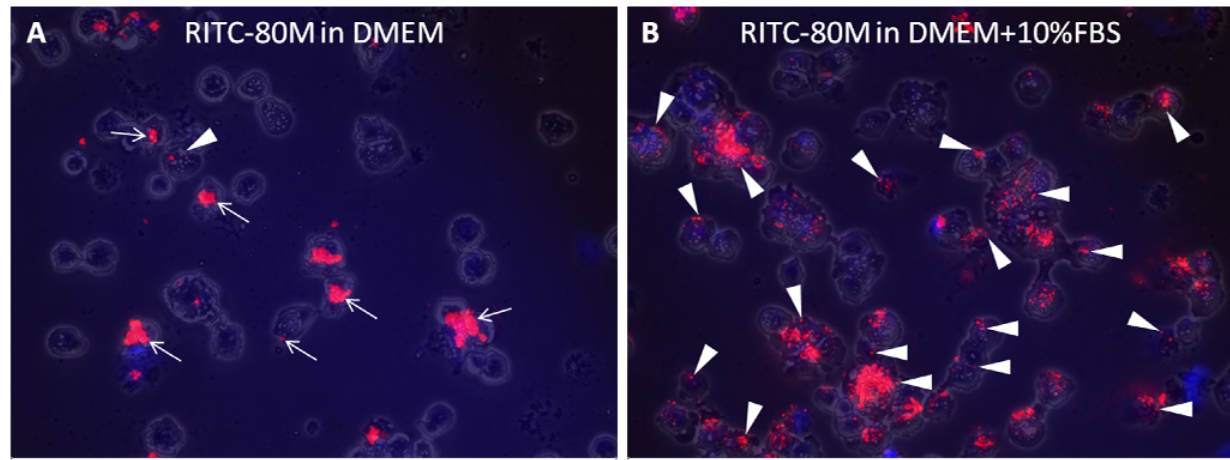
Figure 8. Merged epifluorescent-brightfield images of cytospins of HEK293 cells submitted to flow cytometry after culturing 24 hours with RITC-80M in DMEM ( A ) or in DMEM+10% FBS pH 7.4 ( B ). Red signal is RITC-chitosan, blue is Hoechst 33346-stained DNA. Symbols: arrows: extracellular RITC-80M adsorbed to cell surfaces as shown by the non-uniform microparticle shape; arrowhead: intracellular vesicles with